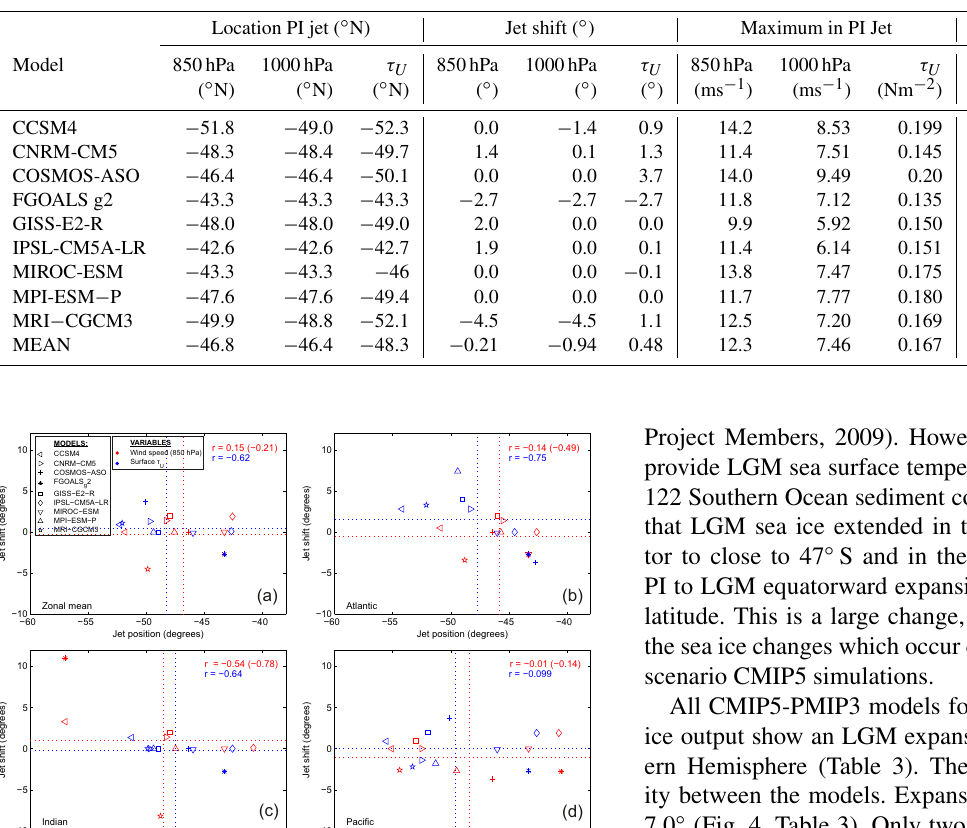
Table 2. The Southern Ocean westerly winds jet position, jet strength, and PI to LGM changes in jet position and strength.